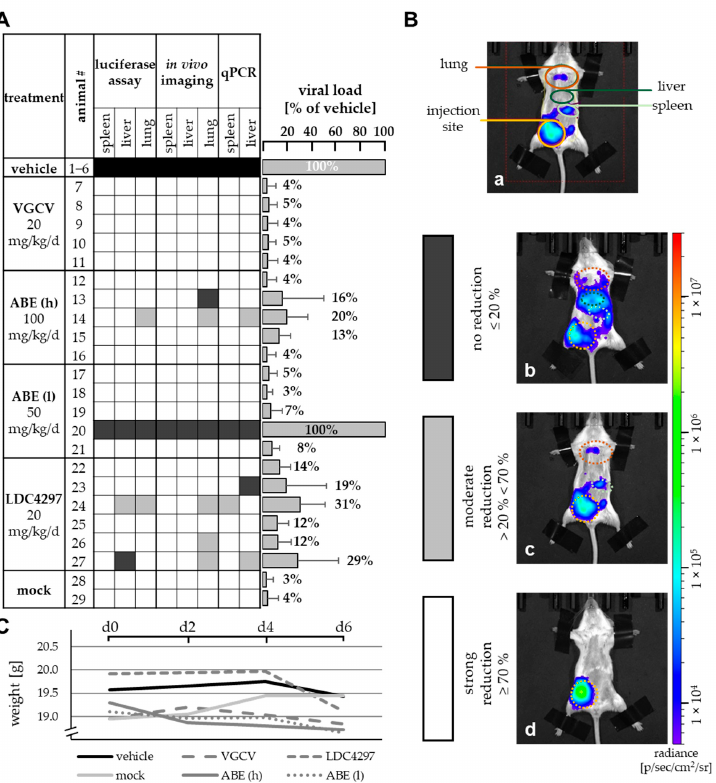
Figure 3. Reduction of viral load by PKI treatment. ( A ) Viral load in spleen, liver and lung was measured using in vitro luciferase assay, in vivo luciferase imaging and viral genome-specific qPCR and was compared to the mean value of viral load of six vehicle-treated mice. No, moderate or strong reduction is indicated by black, grey or white colored boxes, respectively, as indicated in panel B. Grey bars on the right indicate mean values + SD of viral load for each animal in all eight analyzed organs/methods (see also percentages given above of each bar). ( B ) Exemplary pictures of in vivo luciferase imaging. Mice were fixed, sedated and injected with luciferin solution. Organ-specific luciferase activity was measured according to regions of interest marked in image a. Pictures show exemplary animals for the categories used in panel A, i.e., no reduction (image b), moderate reduction (image c), strong reduction (image d). ( C ) Weight of treated animals as determined on days 0, 2, 4 and 6. Data are given as mean weight in each treatment group. VGCV, valganciclovir. 2.3. Assessment of Antiviral Drug Combinations Using an Approach with Both Bliss Independence Checkerboard and Loewe Additivity Fixed-Dose Assays The efficacy of combinatorial antiviral drug treatments in vitro was assessed using the two most approved methods in an affirmative parallel approach, in order to achieve highly reliable quantitative results (Figure 4). Volumes of drug synergy, additivity or an- tagonism (measured as synergy volume in µM 2 %) were determined according to the Bliss independence checkerboard assay [55], and combination indices (CIs) were calculated ac- cording to the Loewe additivity fixed-dose assay [56].